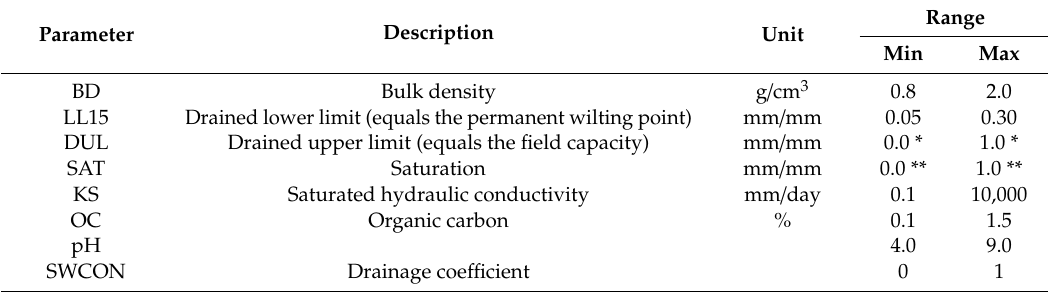
Table 1. Selected soil parameters for the sensitivity